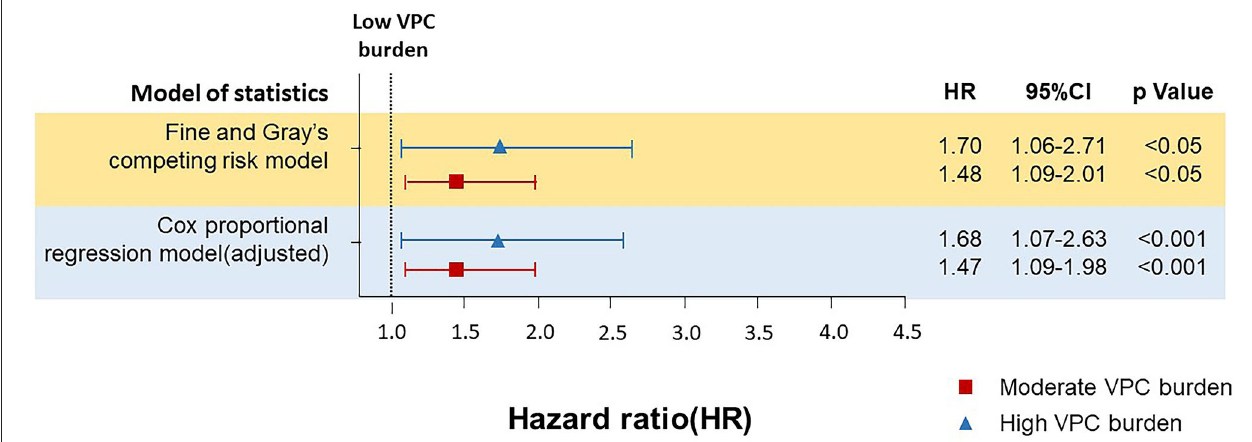
FIGURE 3 | The Cox proportional regression model and Fine and Gray’s competing risk model for analyzing the effect of different burdens of VPC on cardiovascular death. Both Cox proportional regression model and Fine and Gray’s competing risk model demonstrated that in comparison with the low burden group, the moderate burden group showed a higher risk of cardiovascular death. The Cox proportional regression model and the Fine and Gray’s competing risk model was adjusted with baseline characteristics and underlying diseases, including age, gender, diabetes mellitus (DM), dyslipidemia, hypertension, chronic kidney disease (CKD), heart failure (HF), cardiovascular diseases (CVDs), including coronary artery disease, stroke, and peripheral artery disease), ventricular tachycardia (VT), the use of antiarrhythmic drugs (AAD), and beta blocker.